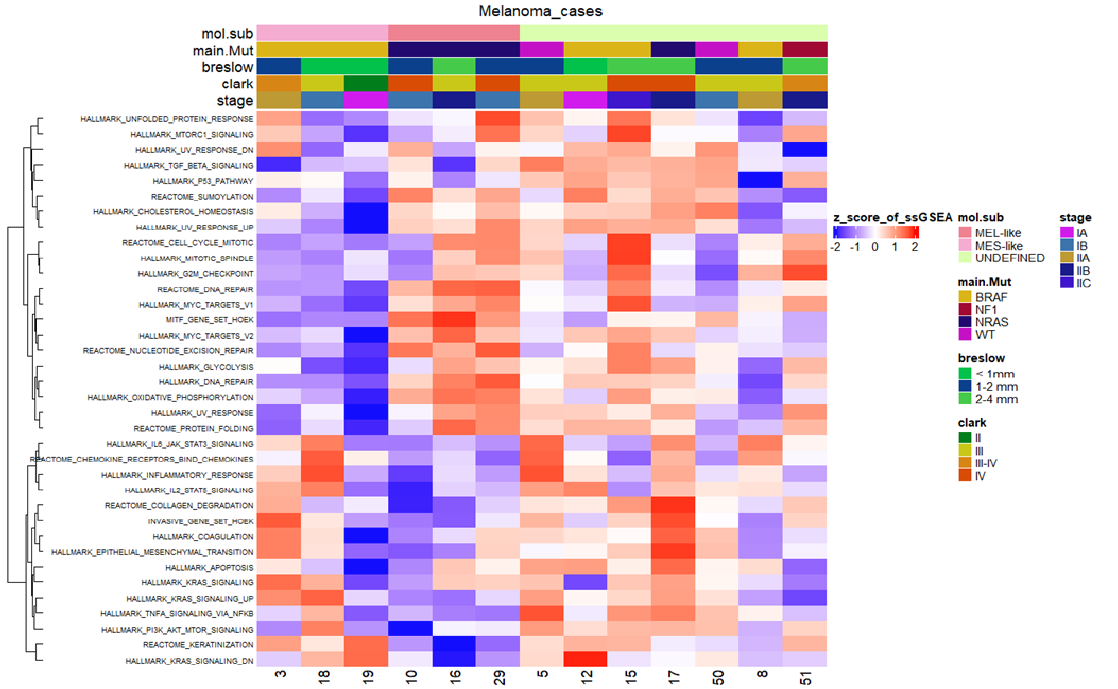
Figure 9. Heatmap of the scaled normalised enrichment scores (NES) of ssGSEA for selected hall- mark/pathway gene sets. Rows are reordered by the method of hierarchical clustering (ward.D2 method, Euclidean distance), whereas columns are ordered based on the respective molecular subtype. Samples with relatively high enrichment of a given gene signature are marked in red and samples with relatively low enrichment are marked in blue. Clinical and molecular information (mutated driver genes) of samples is added at the top as colour bars.